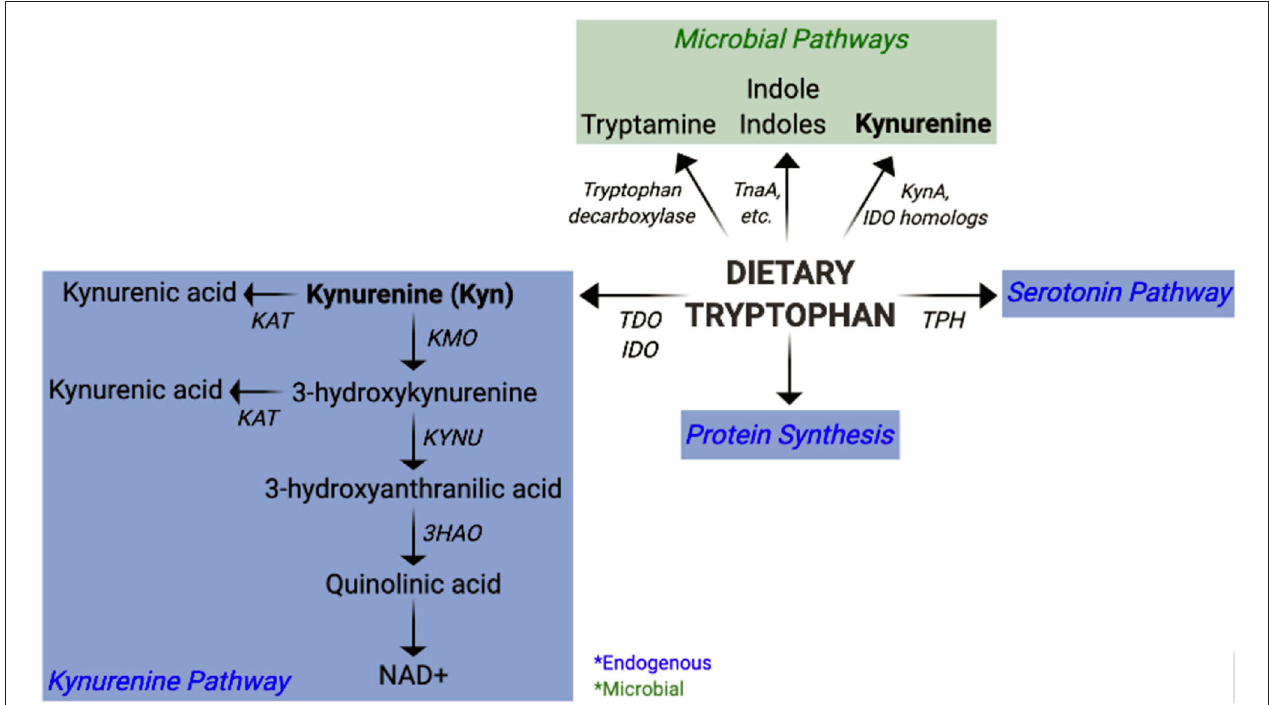
FIGURE 1 | Pathways of mammalian and microbial tryptophan metabolism. Overview of host (endogenous) and bacterial pathways of tryptophan metabolism highlighting kynurenine